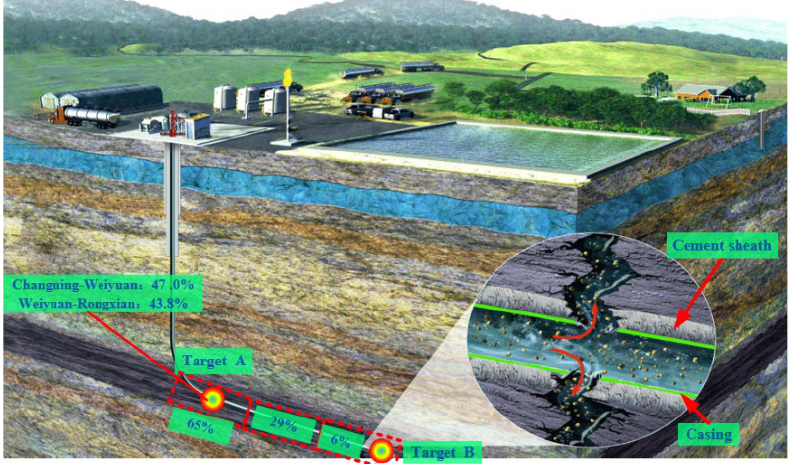
Figure 2. Distribution of casing deformation points of shale gas horizontal well in Sichuan Basin.